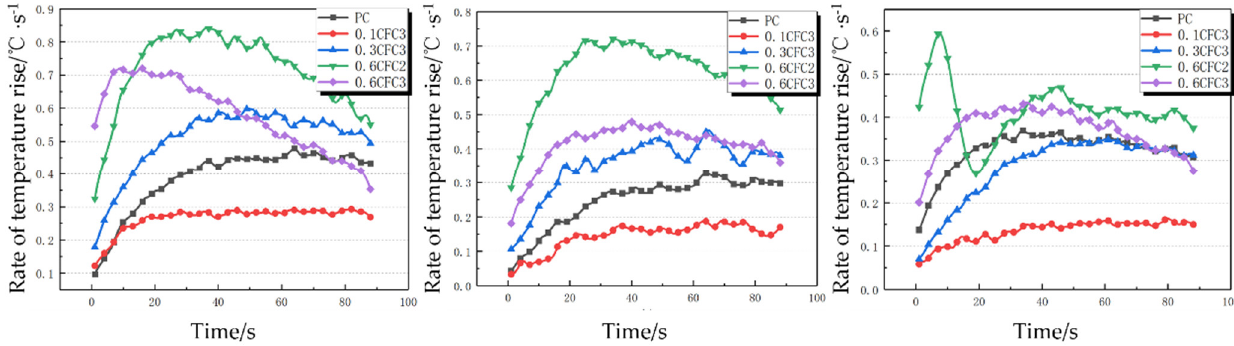
Figure 6. Temperature increase rate at the center point (T 0 ) of modified concrete with different carbon fiber contents and lengths.